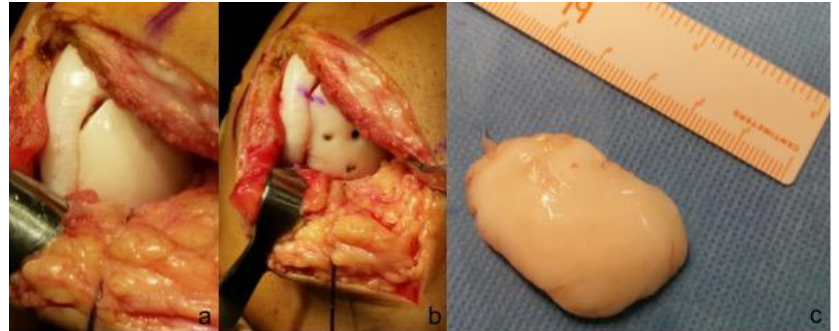
Figure 5. Open reduction and fixation of grade IV OCD with Smart Nails. ( a ) The lesion of the medial condyle was easily individuated; ( b ) after debridement of the subchondral bone the lesion was fixed with four Smart Nails; ( c ) the osteochondral fragment was sized before the fixation.